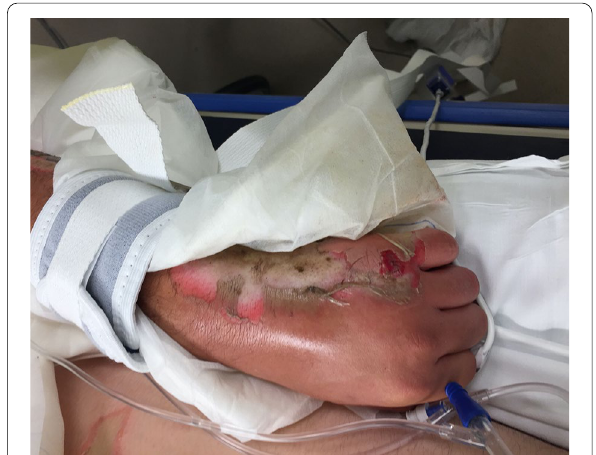
Fig. 2 Electrical injury to left hand and forearm